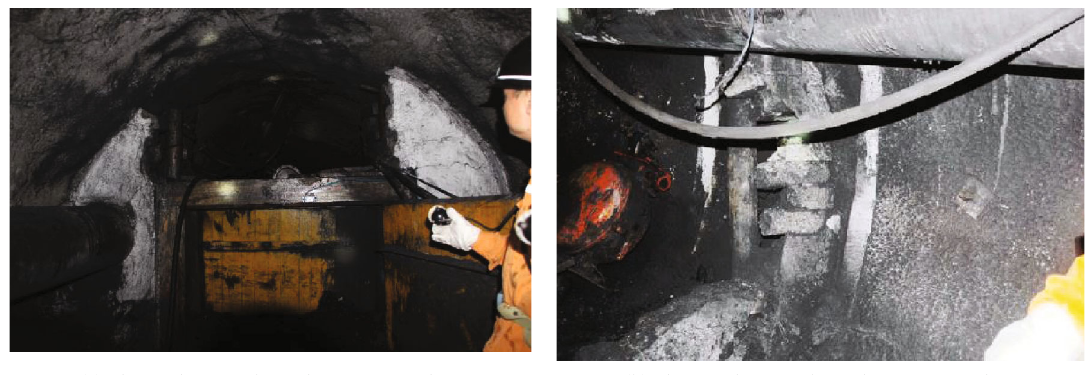
Figure 6: The damaged air doors in scene of